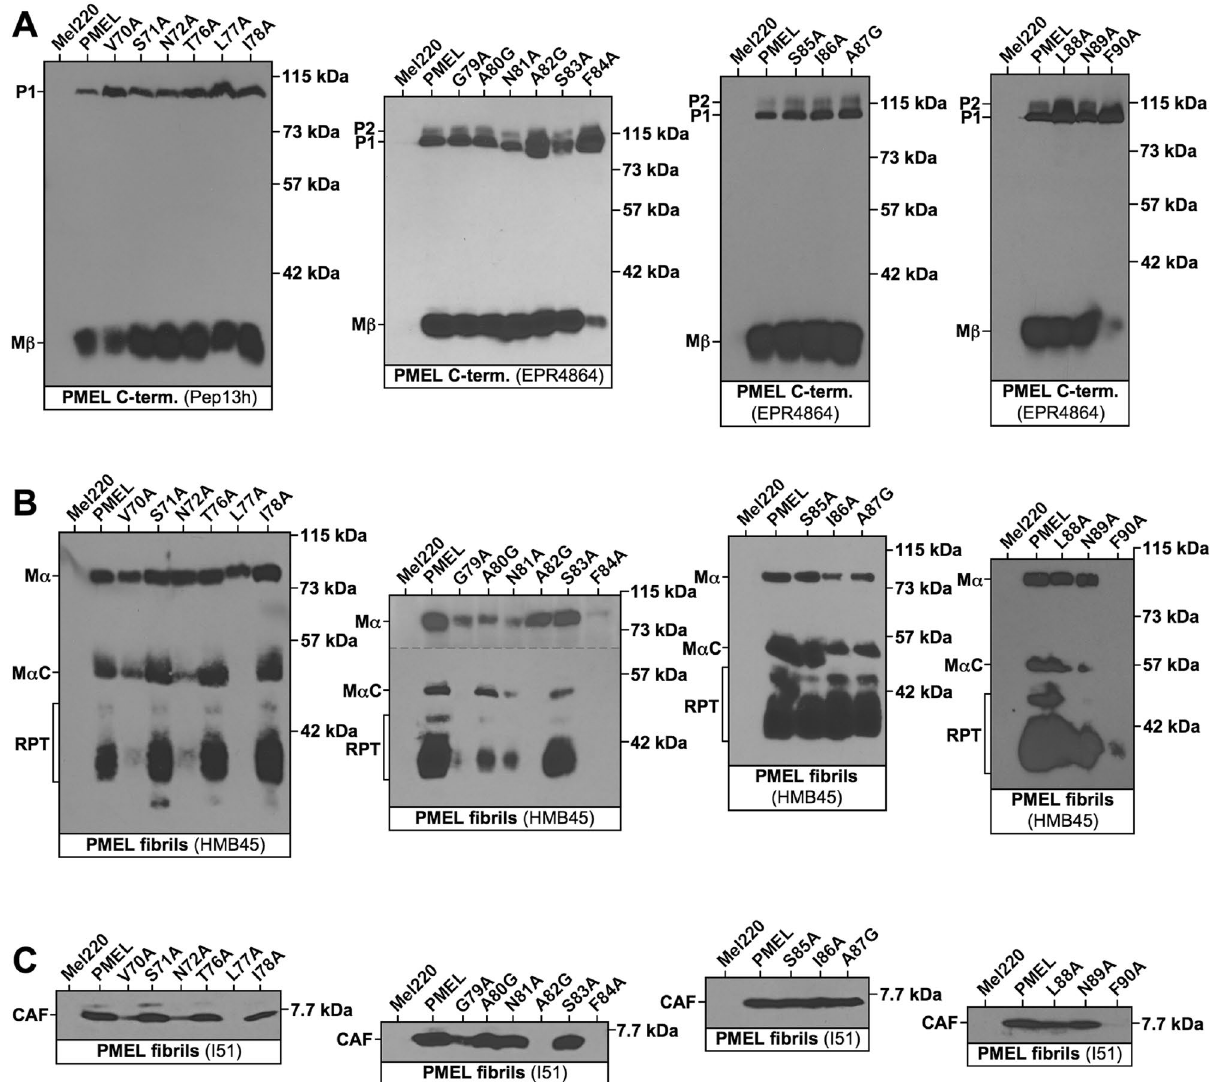
Figure 1. Proteolytic maturation of PMEL alanine-scanning mutants. Western blot analysis of SDS-lysed total membranes derived from Mel220 cells stably expressing PMEL alanine-scanning mutants. ( A ) PMEL-specific antibodies Pep13h and EPR4864 recognize the PMEL C-terminus. Note that P1 represents the ER form of the protein, while Mβ is generated through proteolytic cleavage in secretory compartments after PMEL has been released from the ER. The Mβ:P1 ratio is a measurement of the efficiency with which PMEL exits the ER, which past studies have shown is a good indicator for how well PMEL is folded. ( B ) Antibody HMB45 recognizes the sialylated fibril-associated fragments MαC and RPT. ( C ) Antibody I51 recognizes the fibril-forming CAF. Horizontal dashed lines separate different exposures of the same